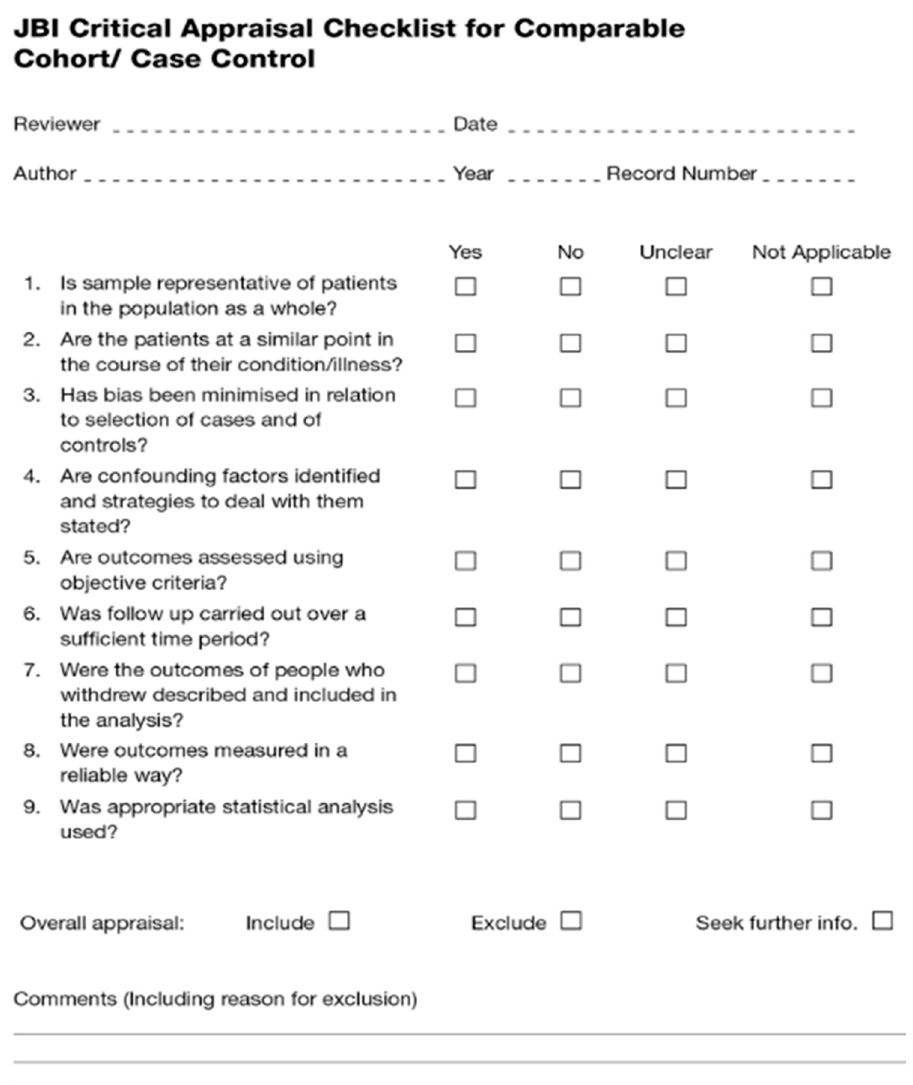
Figure A2. JBI Critical Appraisal Checklist for Comparable Cohort / Case